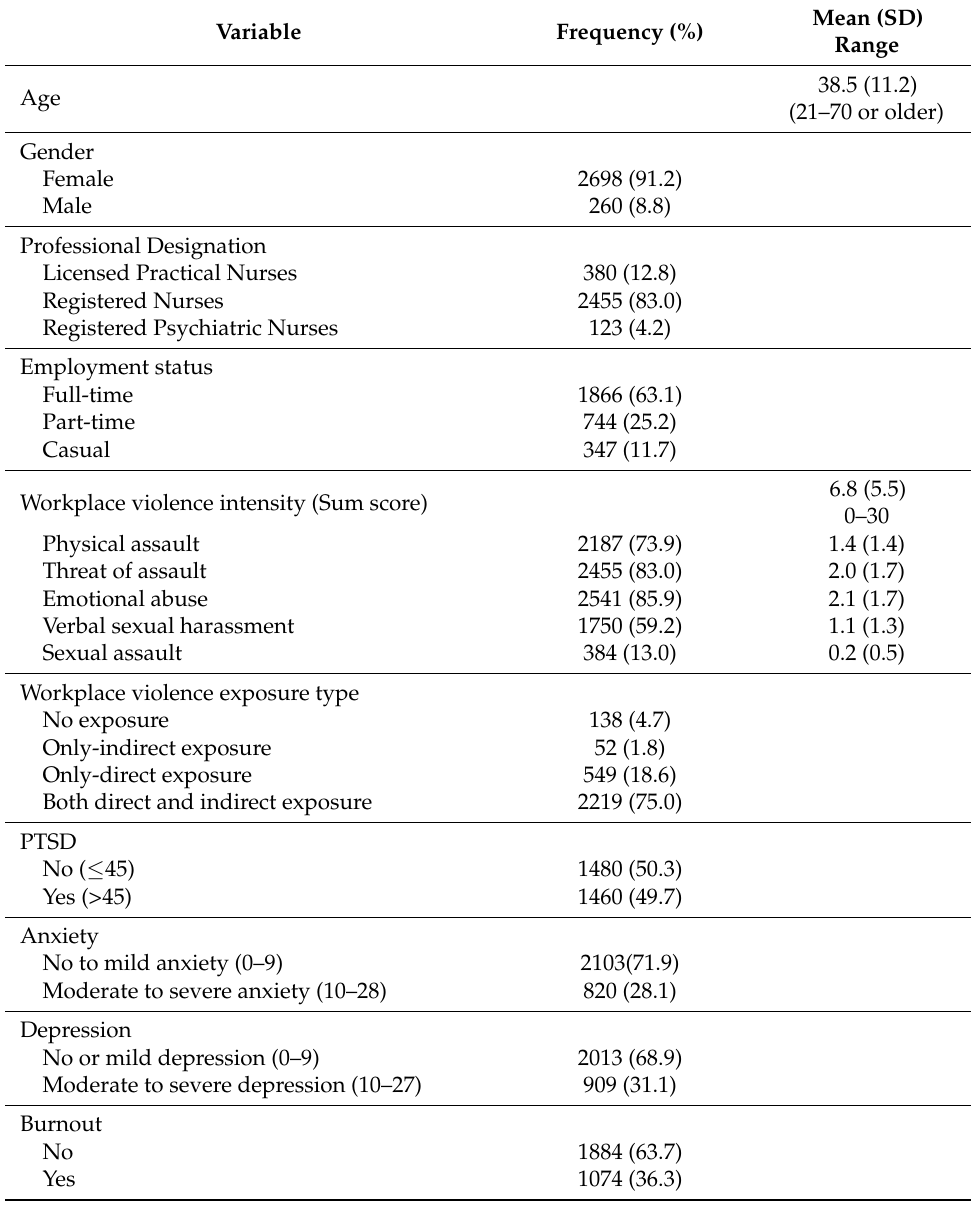
Table 1. Descriptive statistics on demographics and key variables ( N =